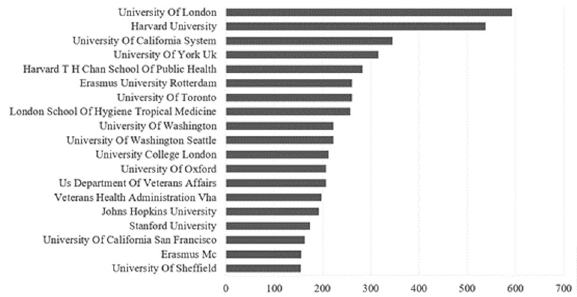
Fig. 4 Publications by institution. Source: Web of Science,